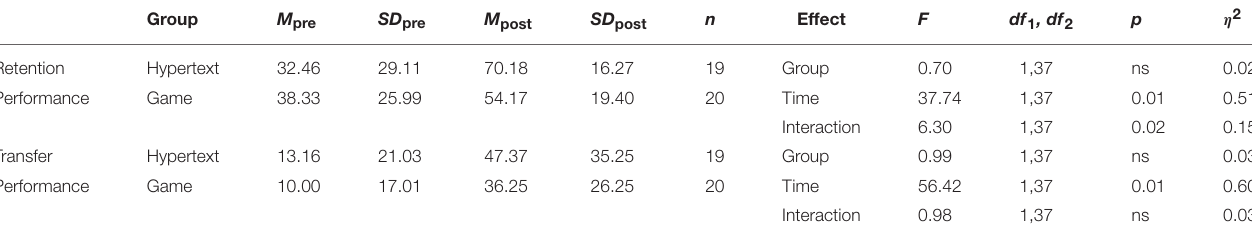
TABLE 6 | Descriptive statistics and the test results of the retention and transfer performance analyses. Group M pre SD pre M post SD post